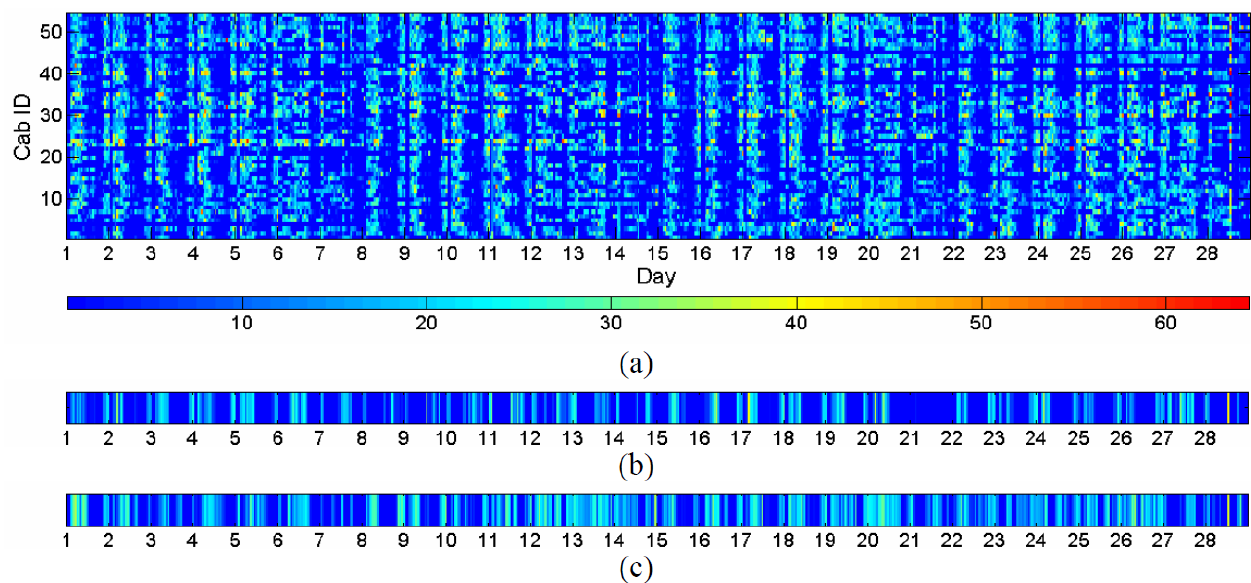
Figure 9. CTS for individual taxicabs (Note: in this graph, the x-axis is the time dimension with hourly units but labeled as day for clarity (e.g., 1 in x-axis is the date 2007-10-01 00:00), while y-axis represents the ID of each taxi cab; in particular, ( a ) shows the graph of CTS for all taxicabs; ( b ) is an enlarged graph of the CTS for taxicab No.1; ( c ) is an enlarged graph of the CTS for taxicab